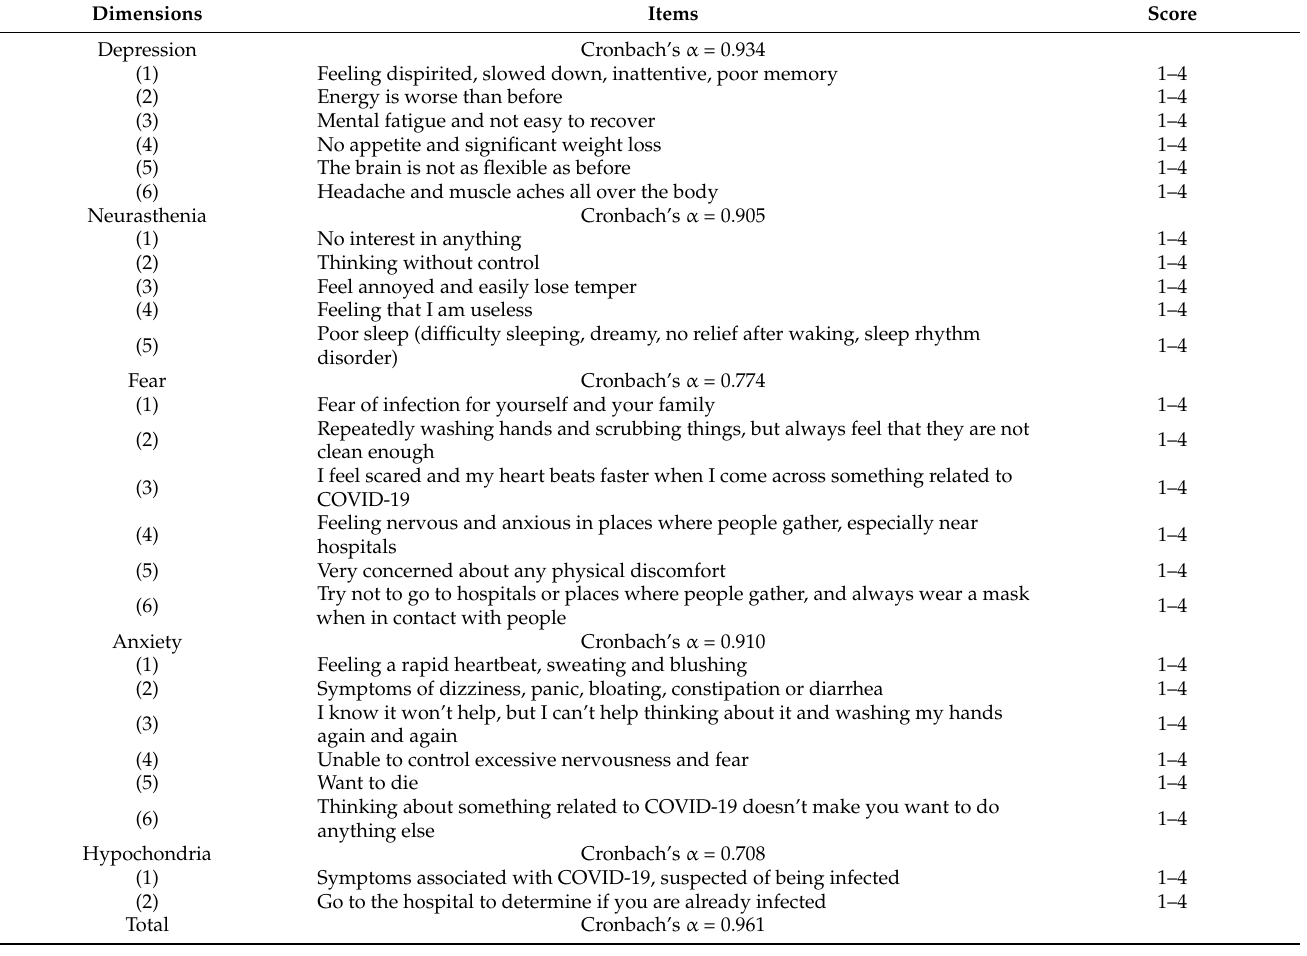
Table 1. Psychological Questionnaire for Emergent Event of Public Health